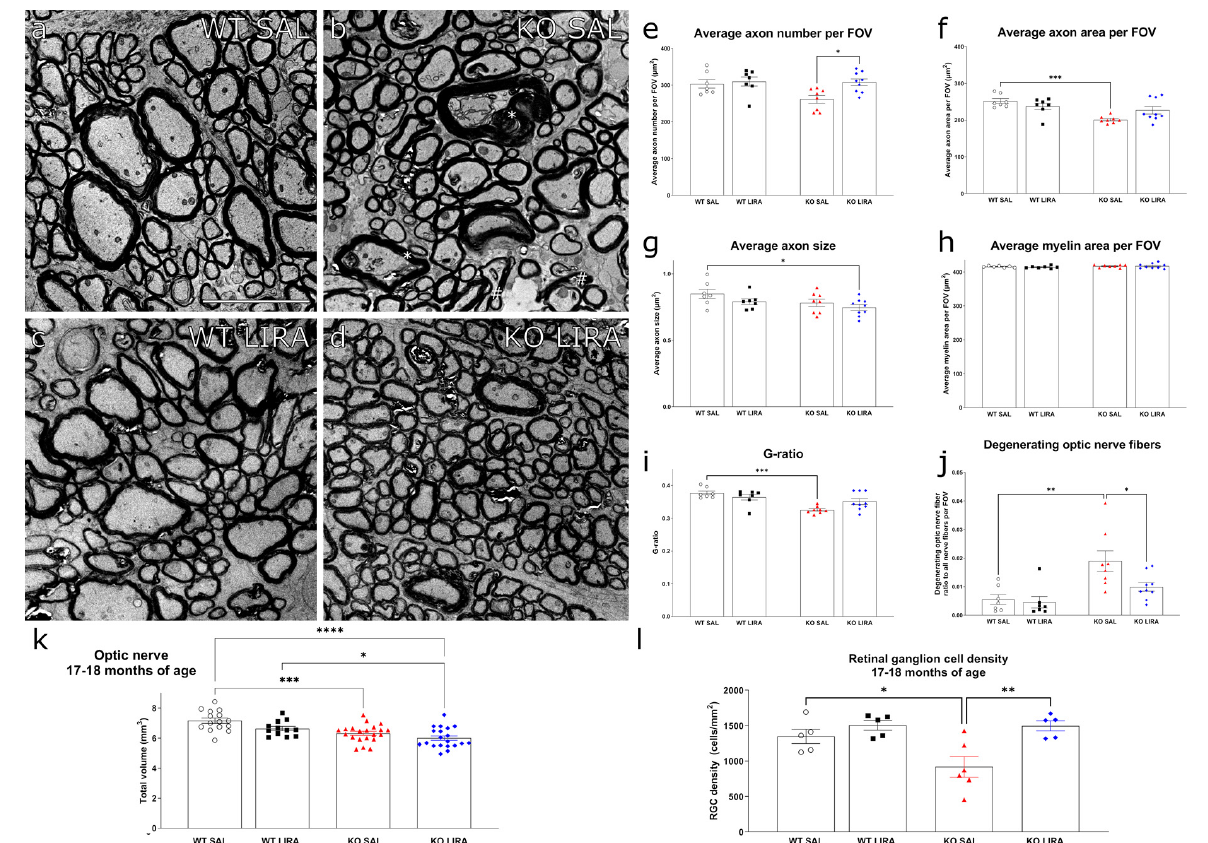
Figure 5. Morphometric analyses of optic nerve and evaluation of ganglion cell density. ( a – d ) Electron micrographs representing optic nerves from corresponding treatment groups. ( b ) Large caliber optic nerve fibers (asterisk) display several degeneration signs: severe vacuolization and hypermyelination. Axonal compression (hash) is observable throughout the optic nerve. ( e – l ) Graphs displaying measurements of: ( e ) average number of axons per field of view (FOV); ( f ) average area of axons ( µ m 2 ) per field of view (FOV); ( g ) average axon cross-section area ( h ) average myelin area ( µ m 2 ) per FOV; ( i ) area based G-ratio (axon area divided by axon area plus myelin area); ( j ) ratios of degenerating fibers calculated as the ratio of degenerating fibers to all counted fibers per FOV, n = 7–9 per group. ( k ) Volume of optic nerve obtained by analyzing MRI data at 17–18 months of age, n = 12–21 per group. ( l ) Graph displays retinal ganglion cell density at the end of the experiment, at the age of 17–18 months, n = 5–6 per group. Quantitative data were compared one-way ANOVA followed by Tukey’s multiple comparisons test. The data are presented as the mean ± SEM, * p < 0.05, ** p < 0.01, *** p < 0.001, **** p < 0.0001. Scale bar: 5 µ